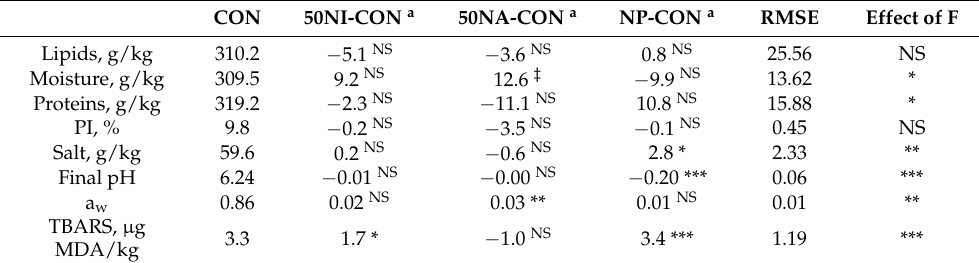
Table 3. Physical chemical parameters of dry-fermented sausages. CON 50NI-CON a 50NA-CON a NP-CON a